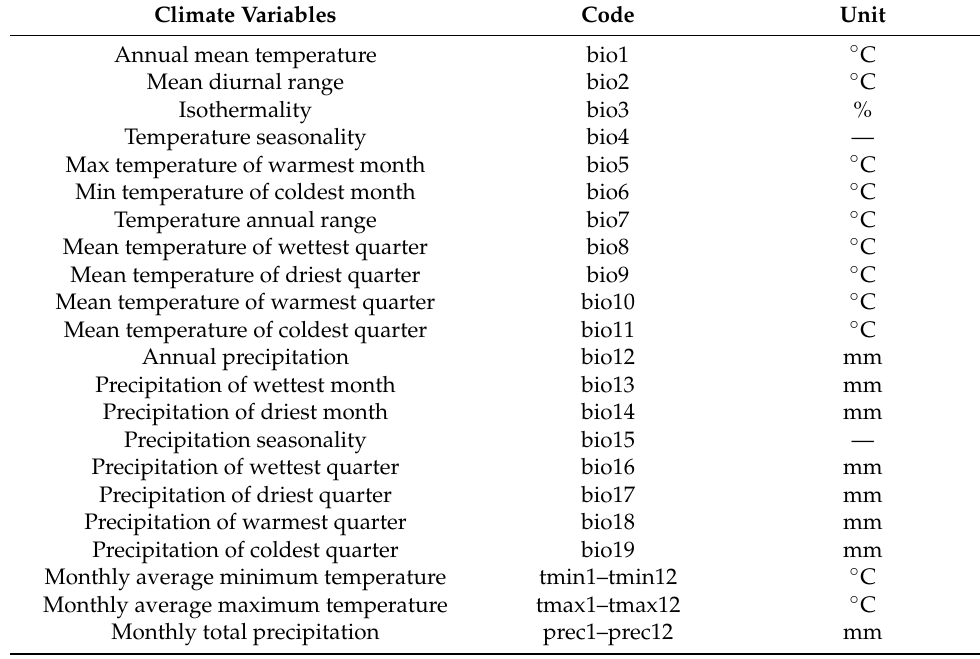
Table 1. Environmental variables used in predicting the potential distribution of S. juvencus